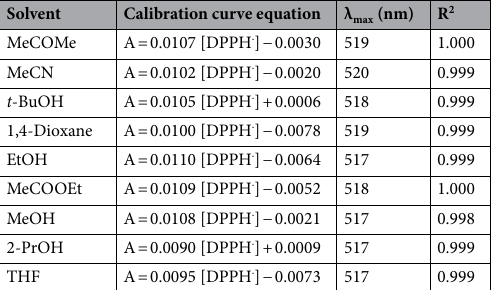
Table 2. Calibration curve equations in triplicate as the absorbance (A) read at the wavelength of maximum absorption (λ max ) versus the concentration (μM) of DPPH free radical in the different reaction solvents.